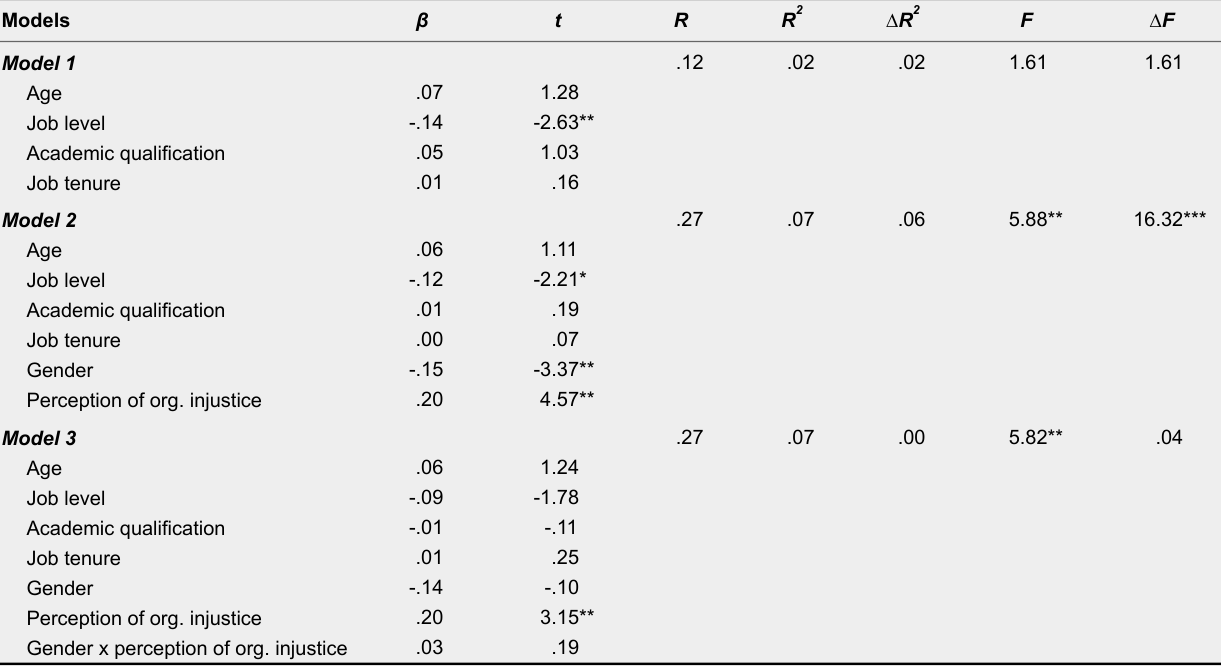
Hierarchical Multiple Regression on Organizational Revenge